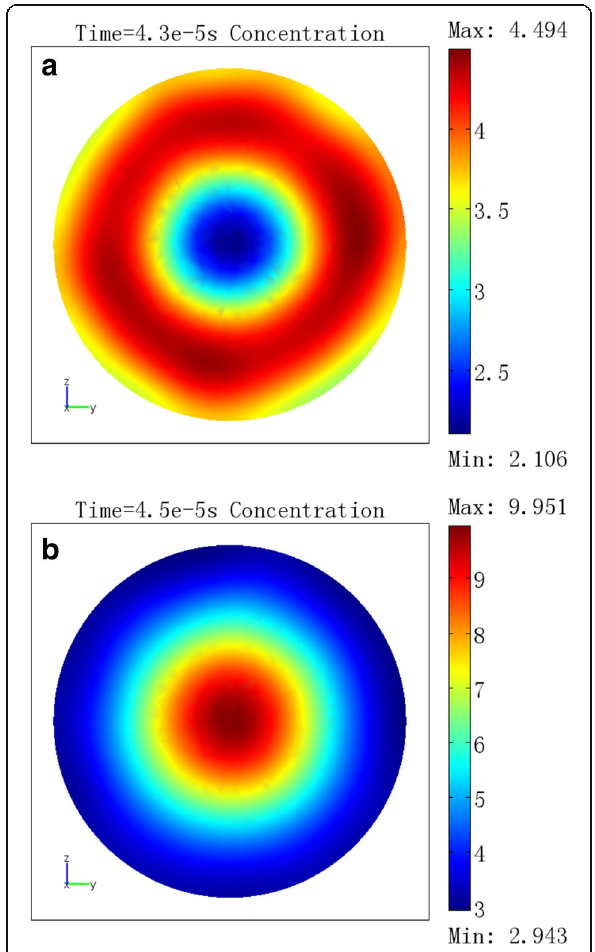
Fig. 3 Concentration distribution. a t = 4.3e − 5 s, section xoy concentration distribution. b t = 4.5e − 5 s, section xoy